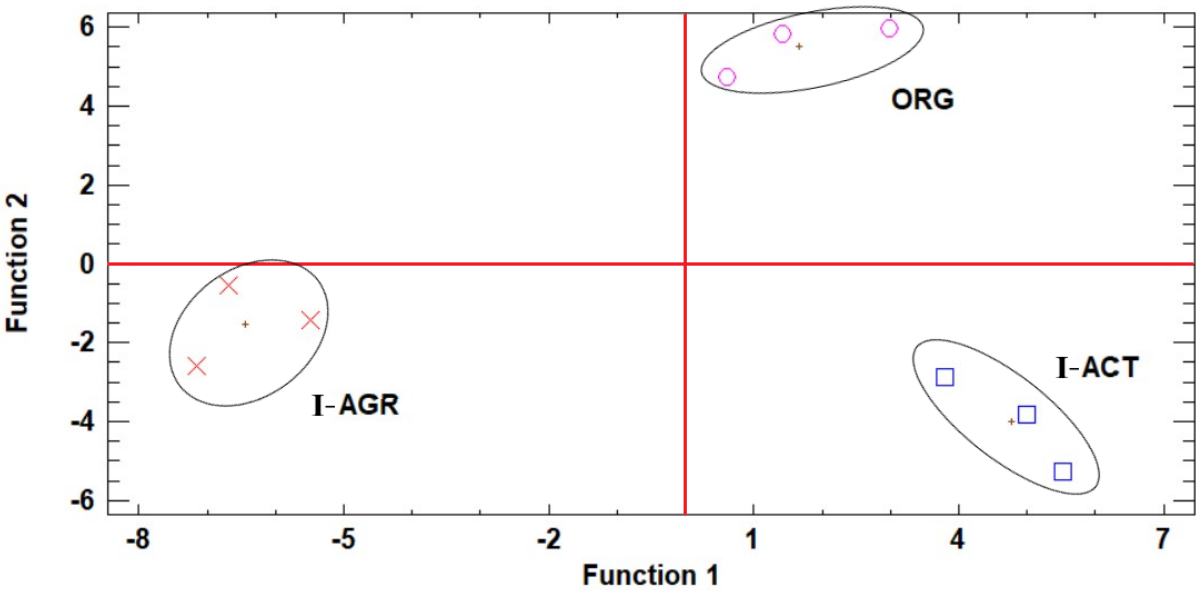
Figure 4. Plot of the discriminant functions produced by the three treatments based on soil characteristics and plant nutrient status. Abbreviations: ORG, organic; I-AGR, integrated based on Agrobiosol amendment; I-ACT, integrated based on Activit amendment.